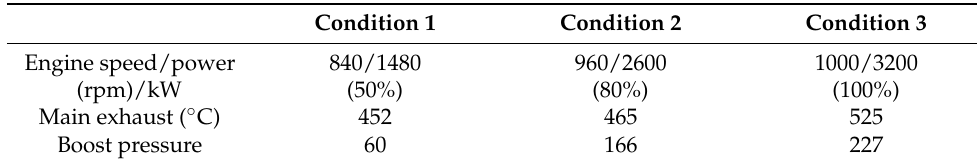
Table 1. Diesel engine test under various conditions.